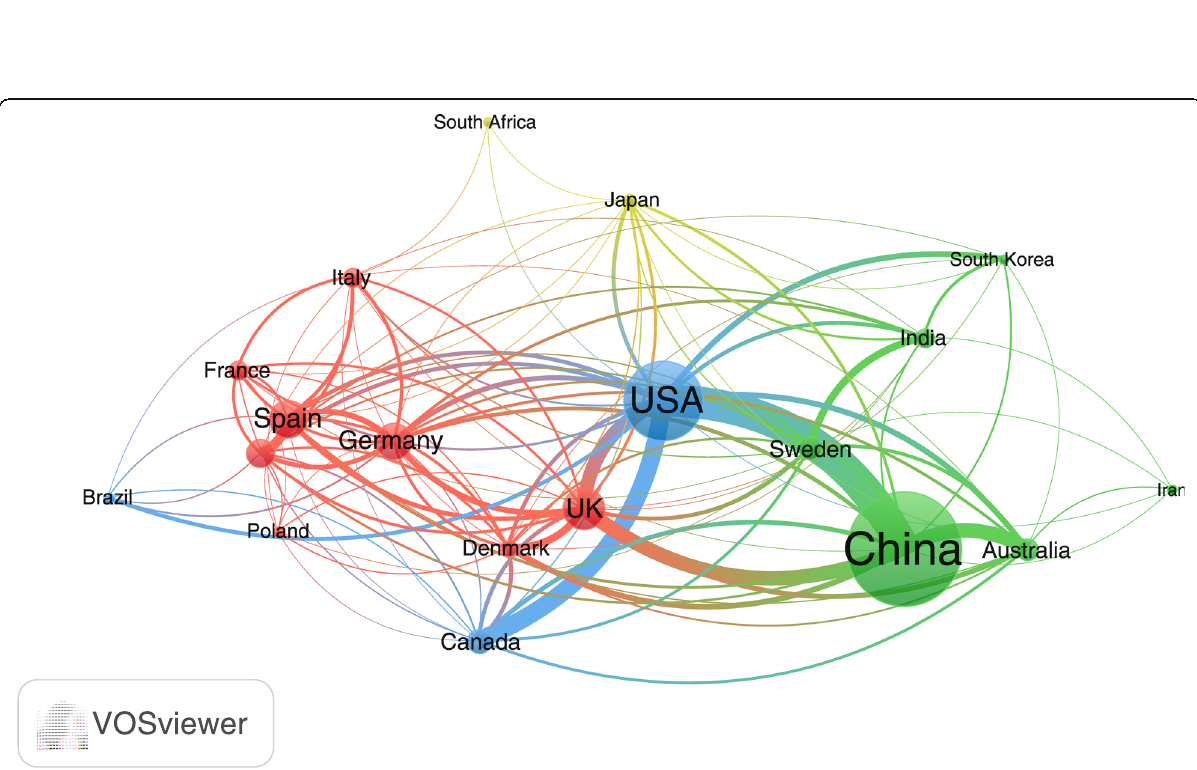
Fig. 5 Network visualization map of scientific impact of publications from countries with minimum research output of 50 documents. Publications from China have the highest scientific impact due to the size of the node representing